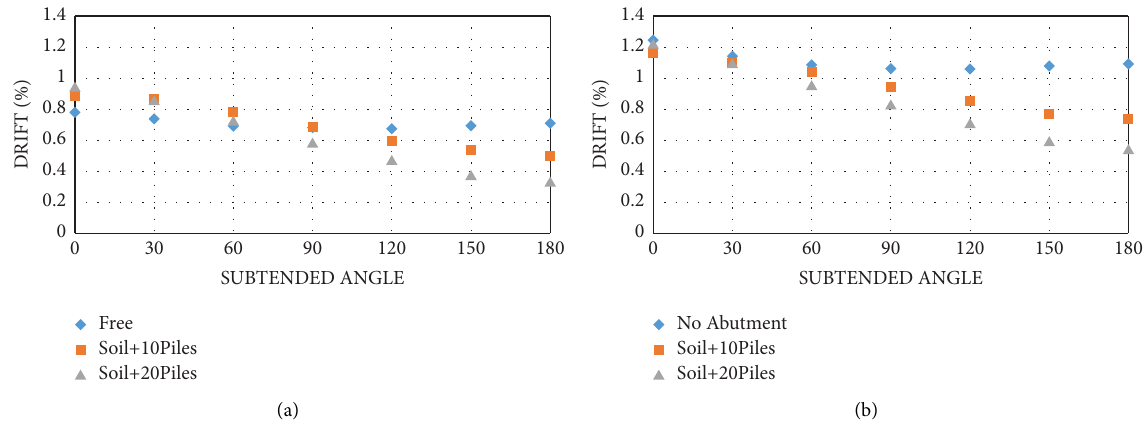
Figure 16: Drift demands of the middle column in all bridge confgurations in the radial direction using GMs compatible to (a) DBE and (b) MCE response spectrums.